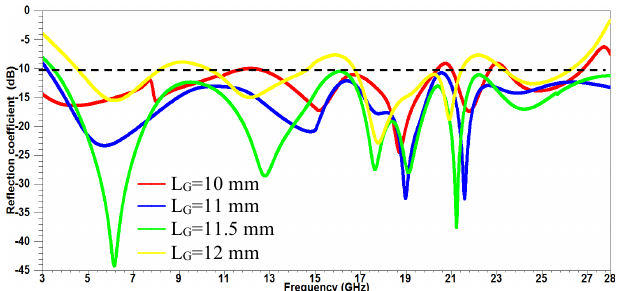
Figure 7: Simulated reflection coefficient for various length of partial ground plane, L G .